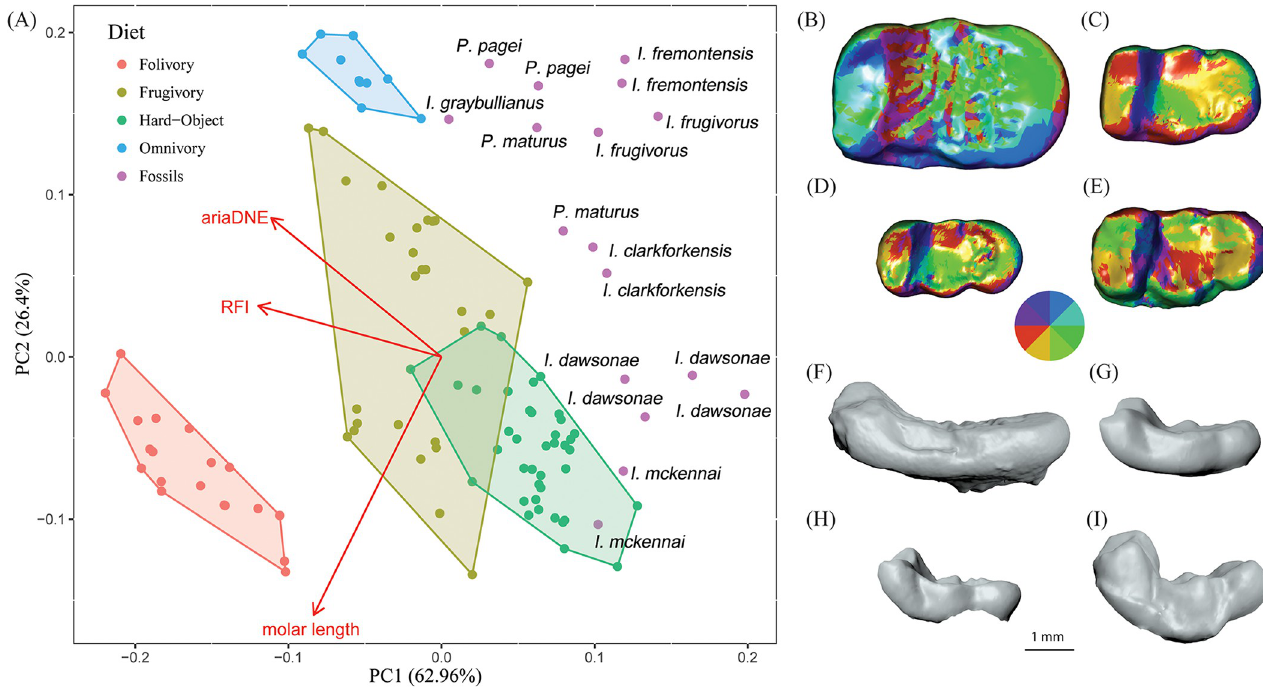
Fig 6. Results of principal component analysis and comparisons of M 3 OPCR and crown height. ( A ) Principal component analysis showing dietary categories of extant platyrrhine primates and their relationship to fossil paromomyids. Shaded polygons represent the extant data points and their respective, assigned dietary categories. Fossil data are represented by purple circles. ( B-E ) Comparison of OPCR maps on lower third molars of four paromomyid species showing the increased complexity due to high enamel crenulation in Ignacius dawsonae (B) . ( F-I ) Buccal views of the corresponding teeth to show differences in crown height among paromomyids. ( B, F ) Ignacius dawsonae (CMN 30889); ( C, G ) Ignacius clarkforkensis (UM 108210); ( D, H ) Phenacolemur pagei (YPM-PU 14030); ( E, I ) Paromomys maturus (USNM 9542).